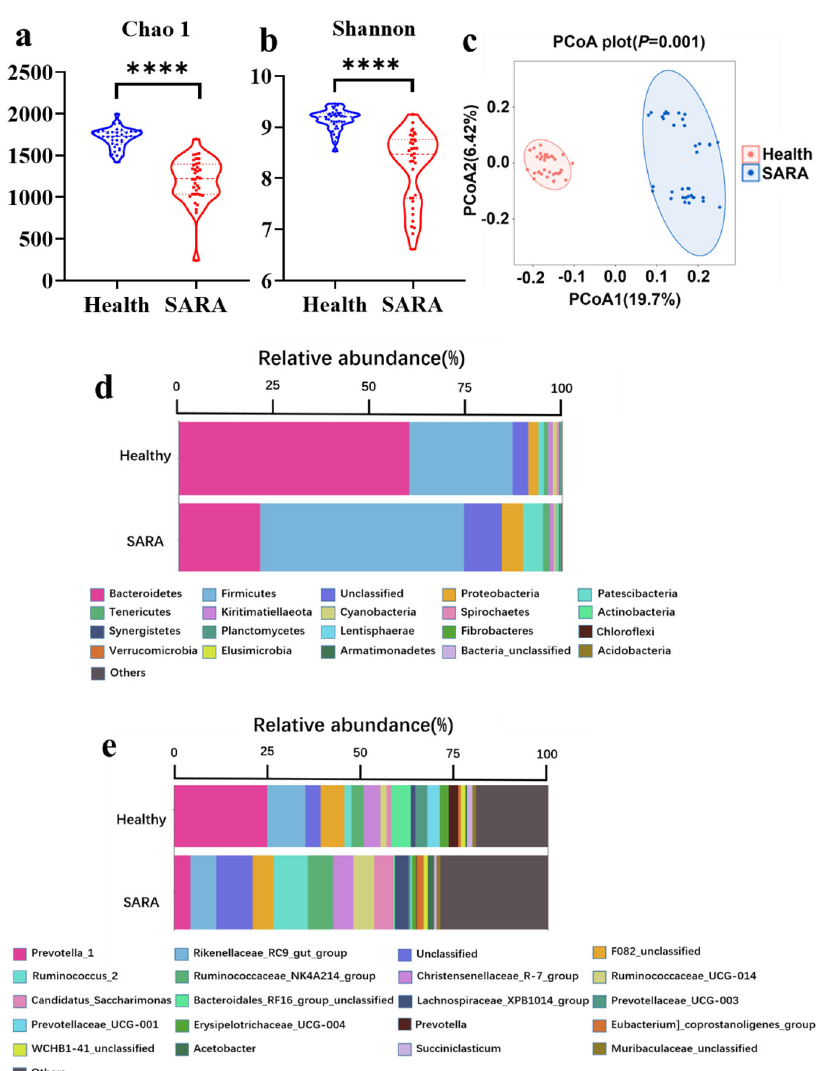
Fig. 2 Rumen microbial composition of two groups of dairy goat donors. a The Chao 1 index and b the Shannon index of rumen microbiomes from two groups of dairy goat donors. A Mann – Whitney U test was carried out for comparing the two groups a , b . c Principal Coordinate Analysis (PCoA) of rumen microbiomes from two groups of dairy goat donors. The data was statistically analyzed based on ANOSIM analysis. d Average relative abundance of microbiota at the phylum level and e average relative abundance of microbiota at the genus level in SARA and healthy groups; Those bacteria whose relative abundance was less than 1% were classi fi ed as others. Health: rumen microorganisms from every hour for 6 consecutive hours after morning feeding of healthy dairy goats, SARA: rumen microorganisms from every hour for 6 consecutive hours after morning feeding of SARA dairy goats. *Indicates the difference is at a signi fi cant level with p < 0.05, **indicates the difference is at a signi fi cant level with p < 0.01. Error bars on the graphs represent standard